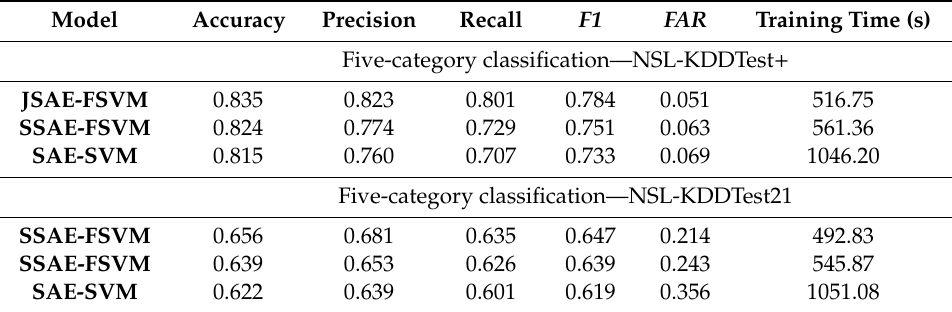
Table 5. Performance in five-category classification tests for three hybrid models. Model